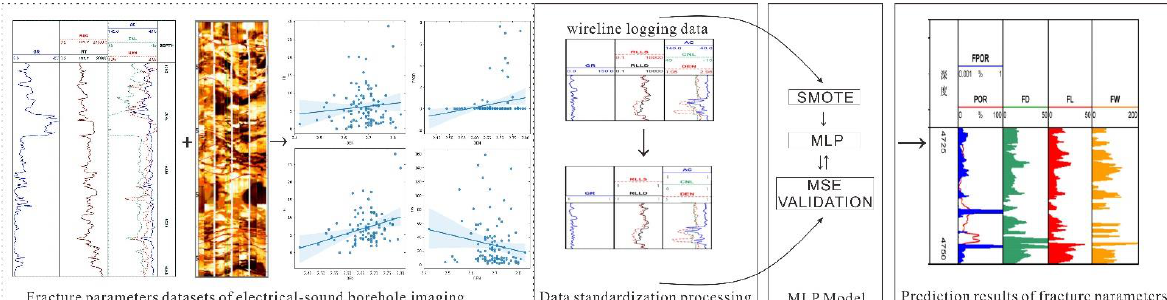
Figure 4. SMOTE and MLP‑based reservoir fracture parameter evaluation model workflow. The dotted boxes denote the data collection process, and the solid frames represent fracture parameter prediction based on the MLP model. In this study, Python and the MLP algorithms from the scikit‑ learn library (http://scikit‑learn.org, accessed on 1 July 2022) were used to predict the reservoir frac‑ ture